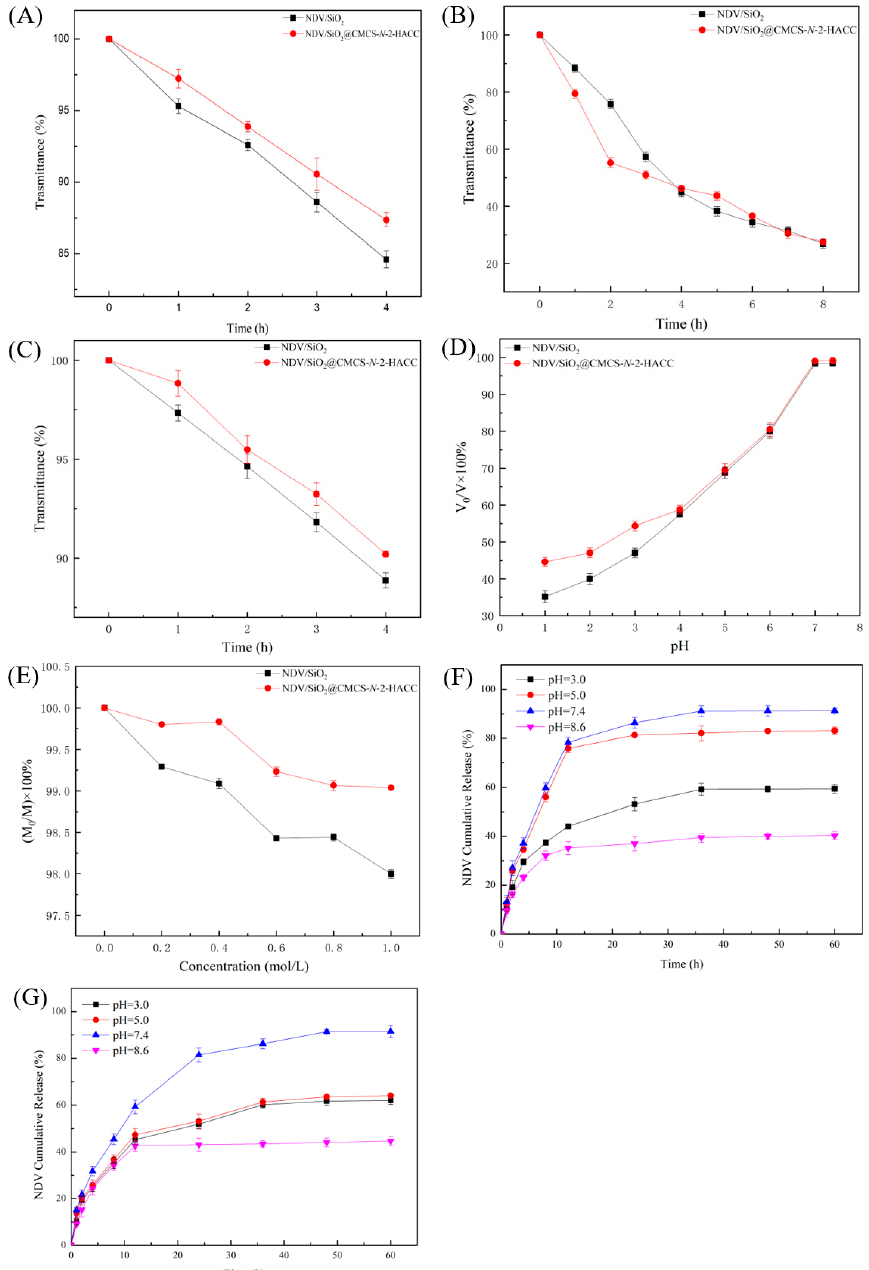
Figure 8. Stability of SiO 2 @CMCS- N -2-HACC nanoparticles and SiO 2 nanoparticles coated antigen: ( A ) acid resistance test of NDV/SiO 2 @CMCS- N -2-HACC and NDV/SiO 2 nanoparticles; ( B ) determi- nation of enteric solubility of NDV/SiO 2 @CMCS- N -2-HACC and NDV/SiO 2 nanoparticles, ( C ) NDV/SiO 2 @CMCS- N -2-HACC and NDV/SiO 2 nanoparticles bile salt resistance test; ( D ) effect of different pH on the stability of NDV/SiO 2 @CMCS- N -2-HACC and NDV/SiO 2 nanoparticles; ( E ) effect of different ionic strengths on the stability of NDV/SiO 2 @CMCS- N -2-HACC nanoparticles and NDV/SiO 2 nanoparticles; ( F ) in vitro release of NDV/SiO 2 @CMCS- N -2-HACC under different pH; ( G ) in vitro release of NDV/SiO 2 nanoparticles under different